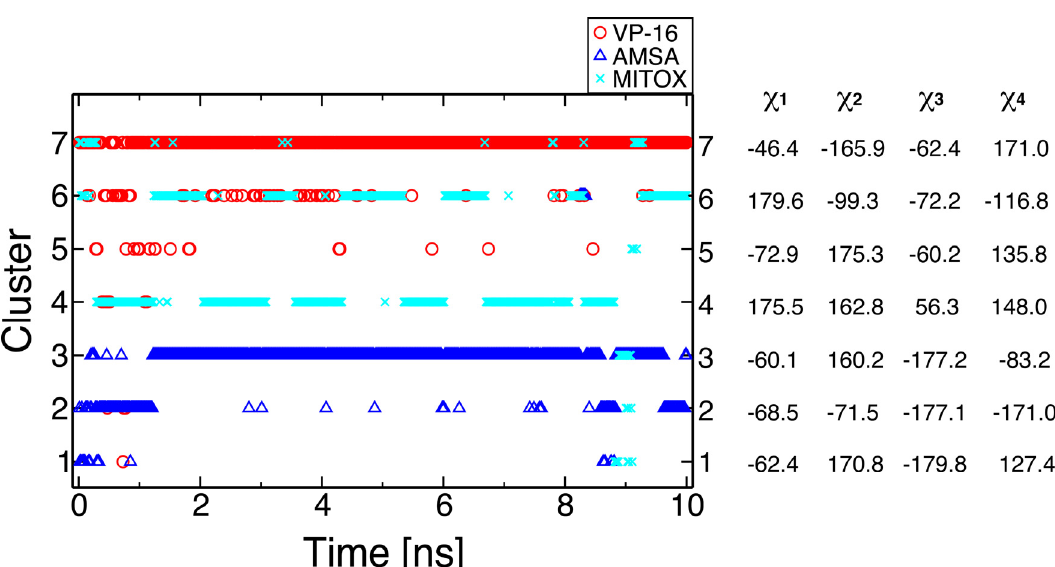
Figure 3. Clustering of the R503 rotamers in TOP2- β cleavage complexes bound with VP-16 (red), m -AMSA (blue) and mitoxantrone (cyan). Clusters 1 and 5 correspond to the crystal conformations of m AMSA-bound and mitoxantrone-bound complex, respectively. Cluster 7 corresponds to the crystal alternate conformation of VP16-bound complex used in the simulation; Cluster 2 corresponds to the other alternate conformation. The dihedrals χ – χ of the cluster centroids are also 1 4